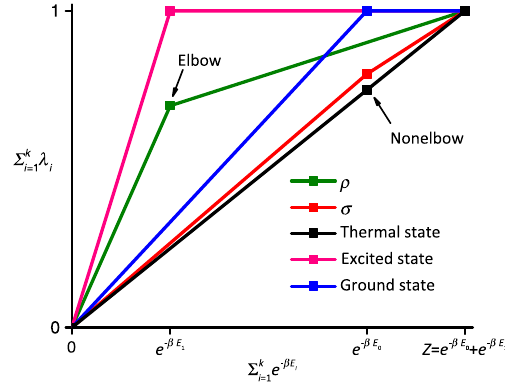
FIG. 2. Thermomajorization curves. Here we plot examples of thermomajorization curves for two-level systems. Observe that states associated with the same Hamiltonian may have different β orderings, as illustrated by ρ and σ here. We say that ρ thermomajorizes σ as the thermomajorization curve of ρ is never below the thermomajorization curve of σ . The thermoma- jorization curve of a Gibbs state is given by a straight line between (0,0) and ð Z; 1 Þ . All other states thermomajorize it. The pure state corresponding to the highest energy level of an n -level system thermomajorizes all other states associated with that Hamiltonian. We call a point on a curve an elbow, if the gradient of the curve changes as it passes through the point. Otherwise, it is a